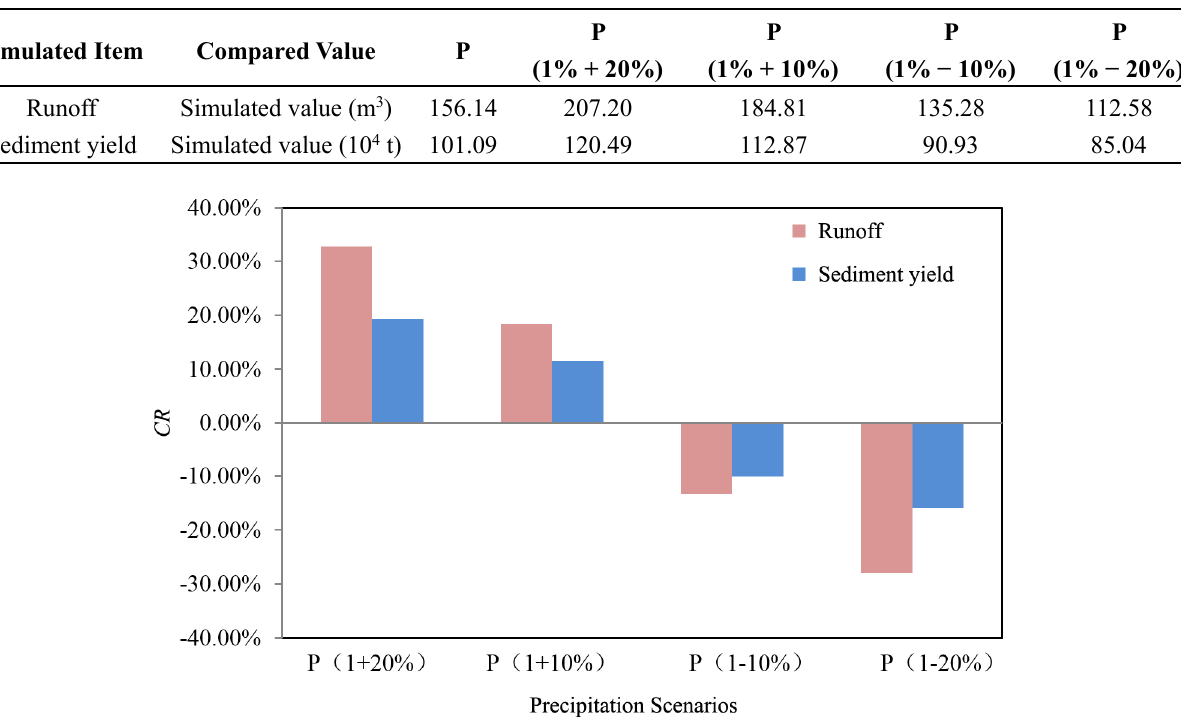
Figure 9. Changing rate of annual runoff and sediment yield change to precipitation